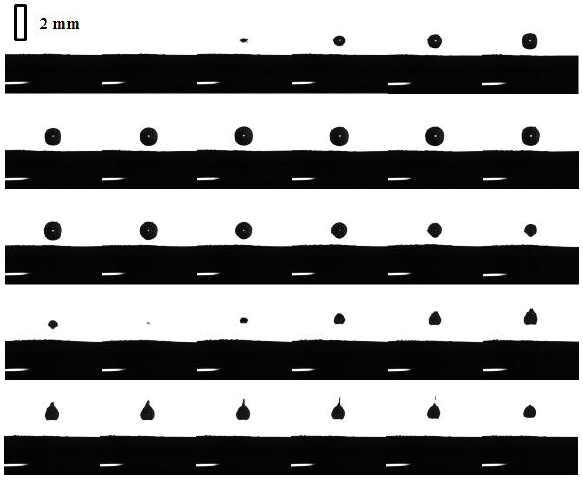
Fig. 4. Bubble dynamics for γ = 1.6. Time between the individual frames is 5.9 µs.